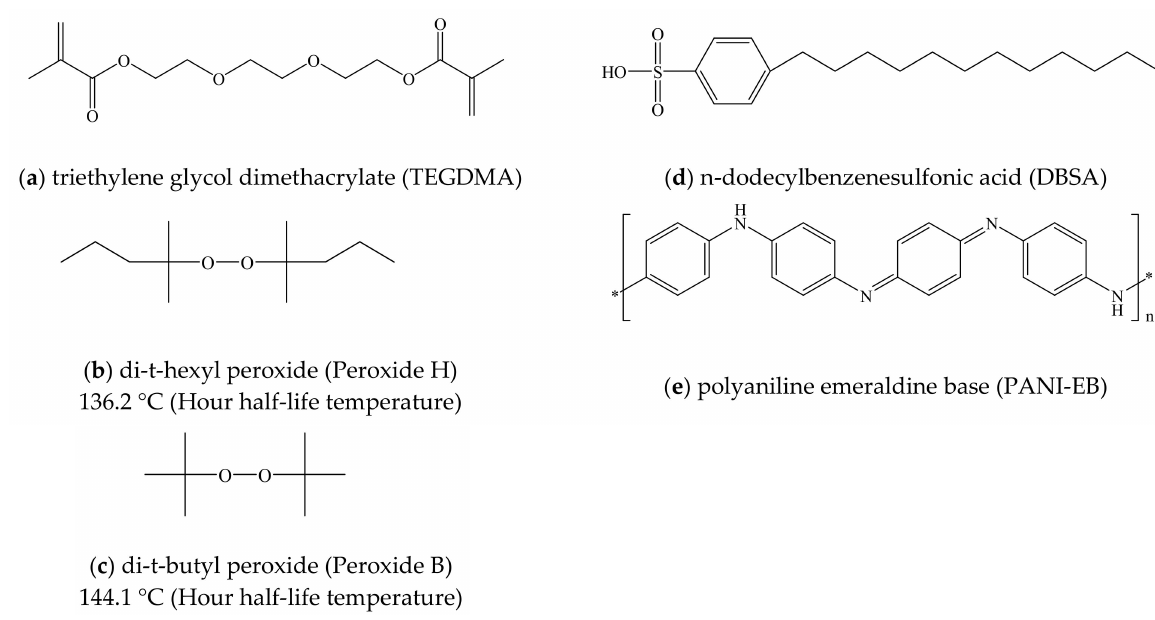
Figure 1. Molecular structures of ( a ) TEGDMA, ( b ) di-t-hexyl peroxide, ( c ) di-t-butyl peroxide, ( d ) DBSA and ( e )